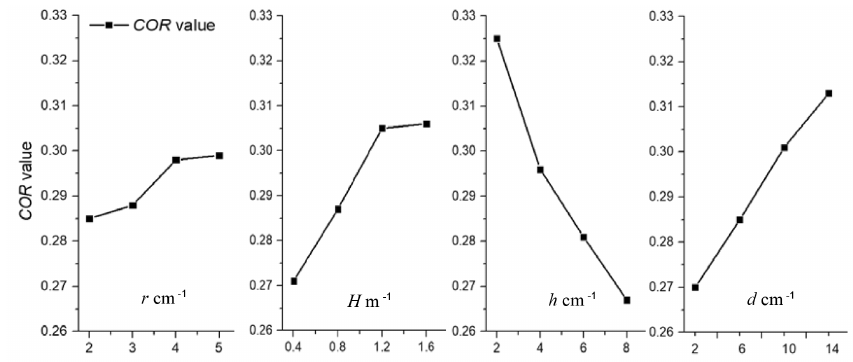
Figure 9. Tendency of each factor as regards the COR of the rockfall–cushion collision.